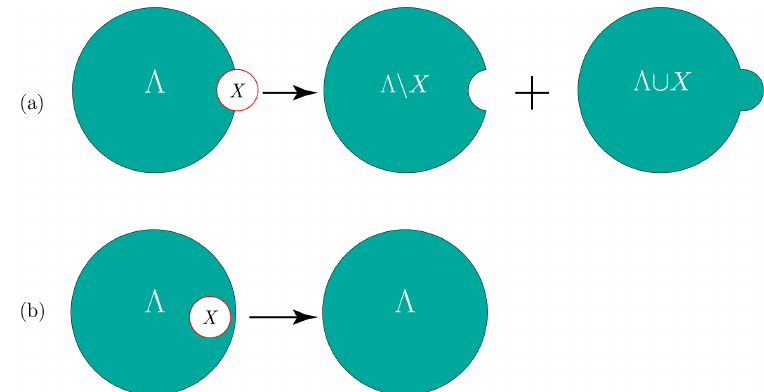
Figure 3: An illustration of the action of the superoperator R T Λ with support on the region Λ ⊂ V . In ( a ) the domain X has a non trivial overlap with the boundary ∂ Λ and, according to Eq.(31), its action gives a linear combination of two domains, namely Λ \ X and Λ ∪ X . In ( b ) the domain X ⊂ Λ is completely contained in Λ and its action is trivial. Note that we neglected the prefactors N and N , cfr. d Λ ∪ X